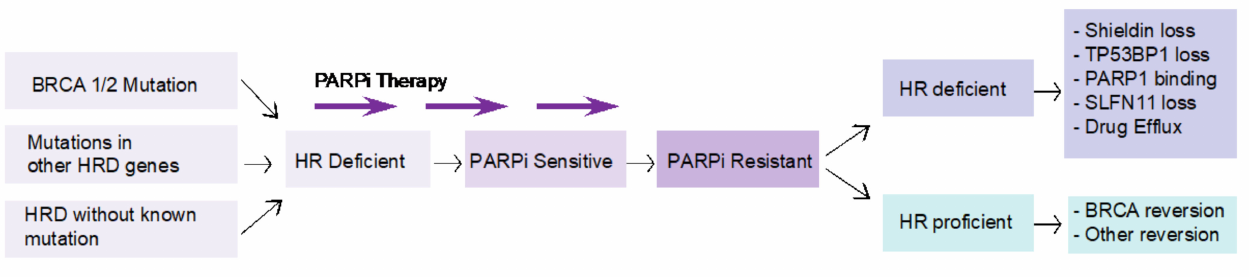
Figure 3. Mechanisms of resistance to PARPi according to HR status. Homologous recombination (HR) deficiency is considered a prerequisite for response to PARP inhibition. Tumors that have acquired resistance to PARP inhibition can be either HR deficient or HR proficient. In HR-proficient tumors, the genetic mutation in the HR gene that results in the HR-deficient phenotype is repaired by a reversion mutation. Mechanisms of resistance to PARP inhibition where the tumor is still HR deficient include loss of activity of the Shieldin complex, TP53BP1 or SLFN11, mutations in PARP1, or enhanced drug